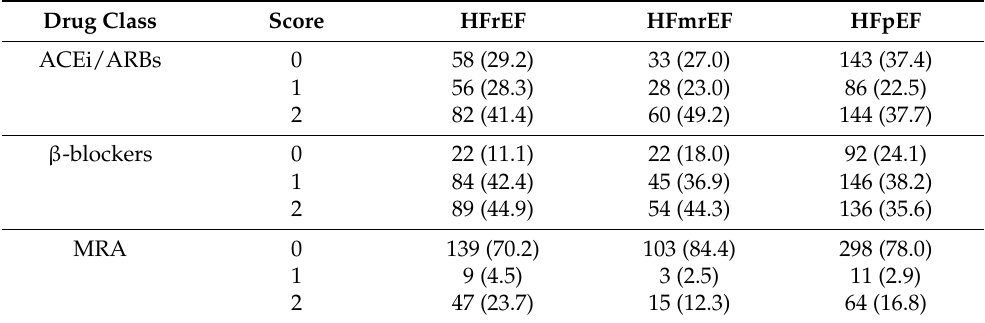
Table 1. Number of patients in each drug class according to the drug class and